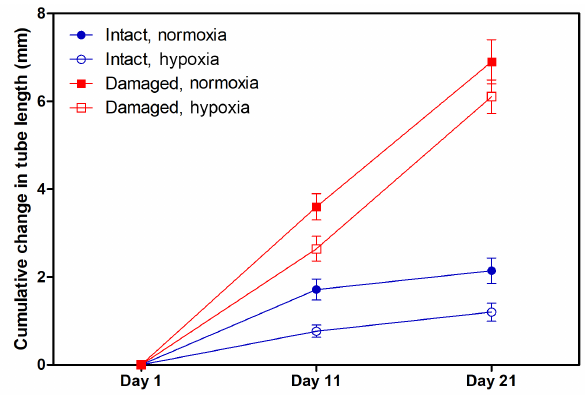
Figure 2. Cumulative change in the tube length of H. diram- phus in different treatments across the 3-week exposure period (mean ± S.E.; n = 30 for “intact, hypoxia” and “damaged, nor- moxia”; n = 28 for “intact, normoxia” and “damaged, hypoxia” due to the